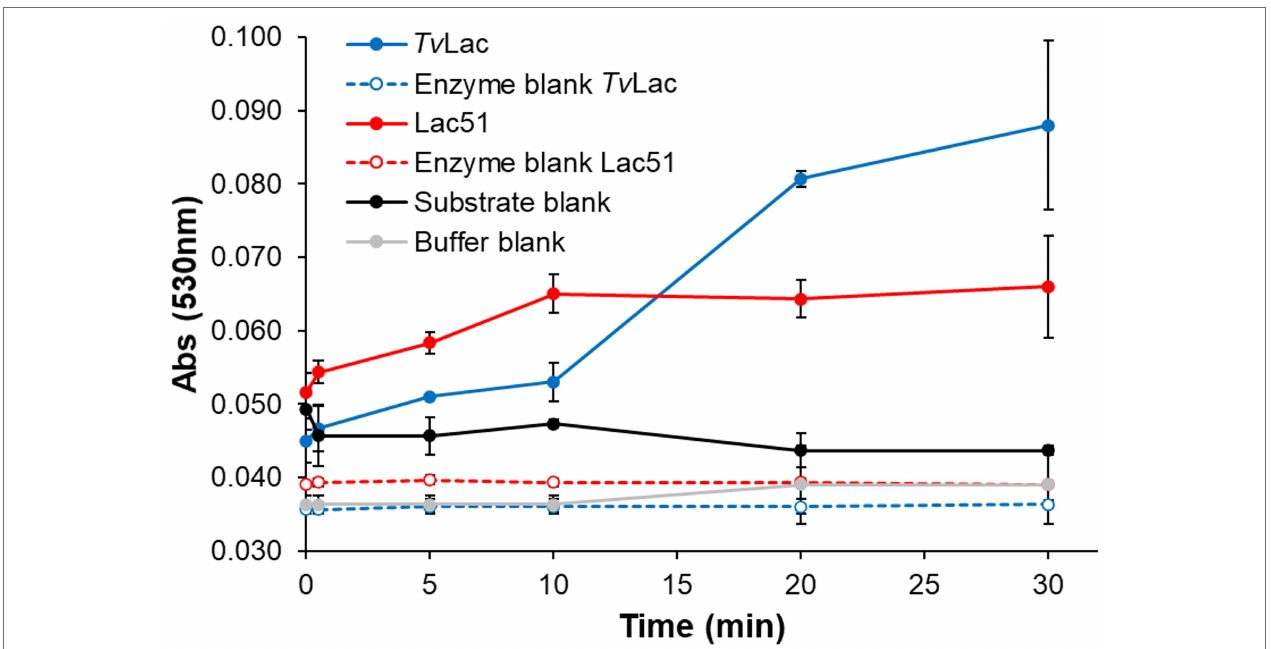
FIGURE 3 | Laccase activity with syringaldazine. Syringaldazine (0.1 mM) was incubated with 0.4 μ M Lac51 (red) or 0.2 μ M Tv Lac (blue) in 50 mM Na-acetate buffer pH 5.0 at 37 ° C. The reaction was followed by detecting the formation of syringaldazine quinone at 530 nm. Substrate (black line) and enzyme blanks (dashed lines) were prepared by omitting enzymes and substrate, respectively; the buffer blank (gray line) lacked both enzyme and substrate. Error bars indicate SD of triplicates.